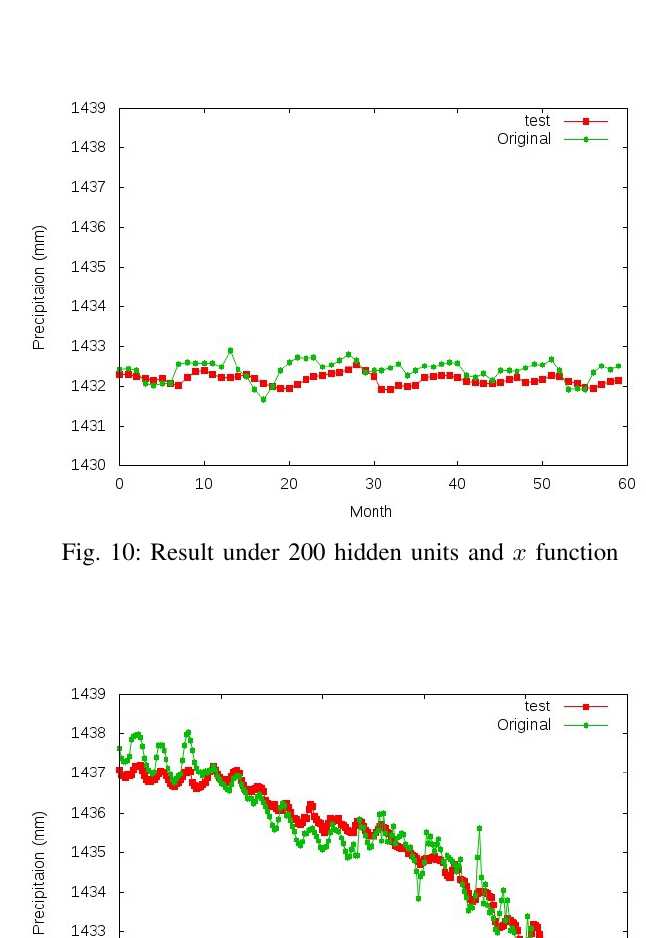
Fig. 9: Training under 200 hidden units and x function